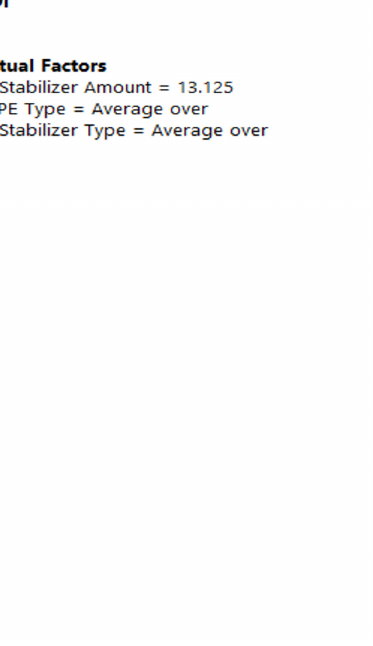
Figure 2. Main effect plots showing the effect of the independent variables; ( A ) stabilizer amount, ( B ) penetration enhancer type, and ( C ) stabilizer type on the PDI of the prepared LCNs.